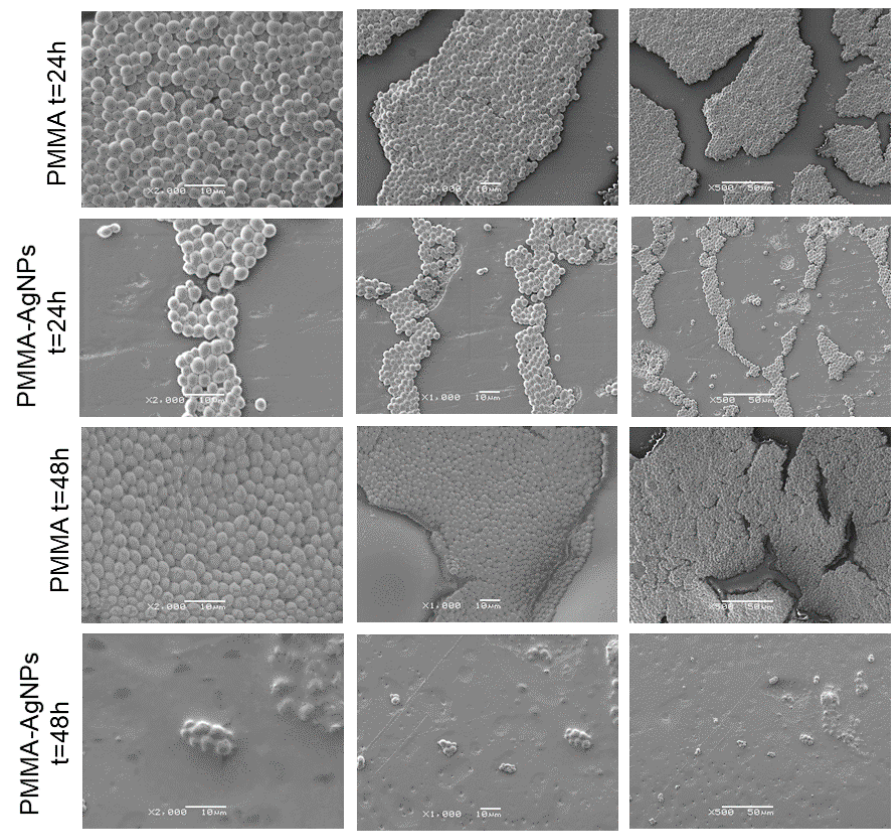
Figure 6. Representative SEM images at 3 magnifications (×2000, ×1000, ×500) of PMMA without NPs and after the addition of PMMA–AgNPs C2 (3.5 wt%) at different time points (24 h and 48 h).